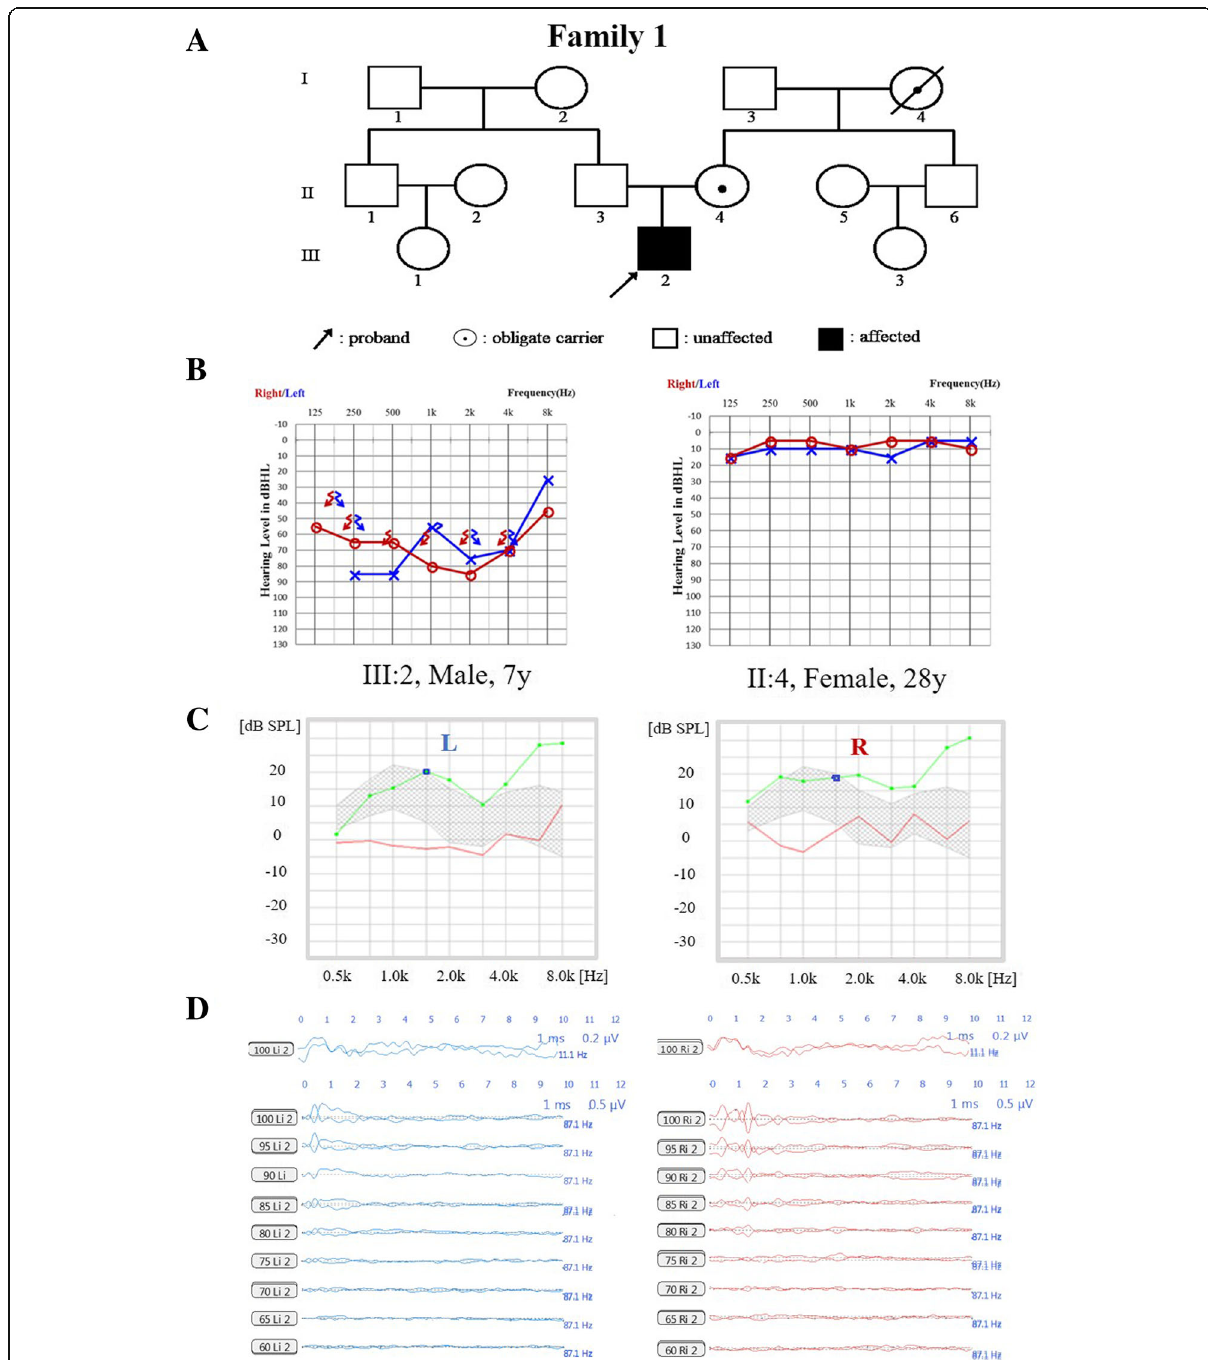
Fig. 1 Pedigree and audiological phenotype of Family 1. a Pedigree of Family 1. The affected subject is coloured black, the proband is indicated by an arrow, and unaffected members with black spots indicate obligate carriers of the causative variation. b Audiograms of the proband (III:2) and his mother (II:4). c Normal DPOAE result of the proband. d Absence of ABR waves and present CM waves in the proband. L, Left, blue; R, Right,